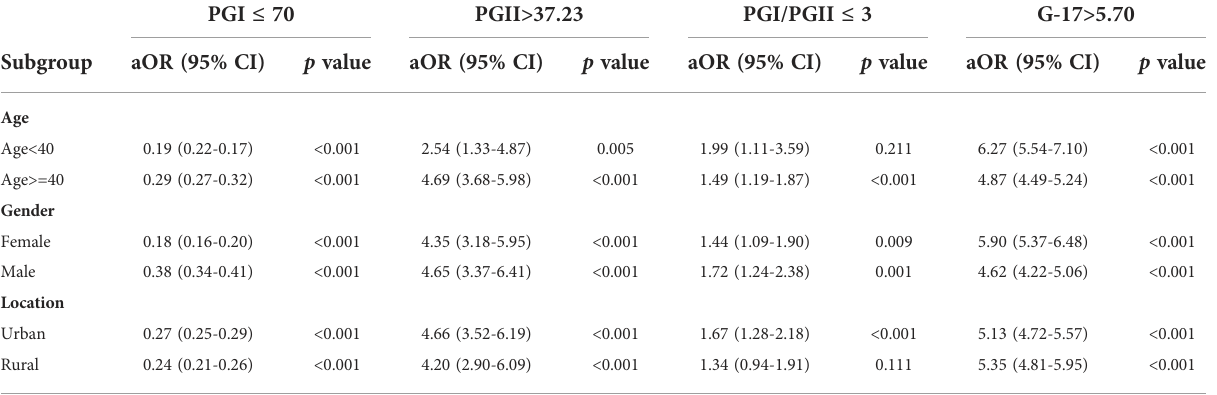
TABLE 3 Subgroup analysis of adjusted ORs for abnormalities of serum PGs and G-17 in H. pylori -positive